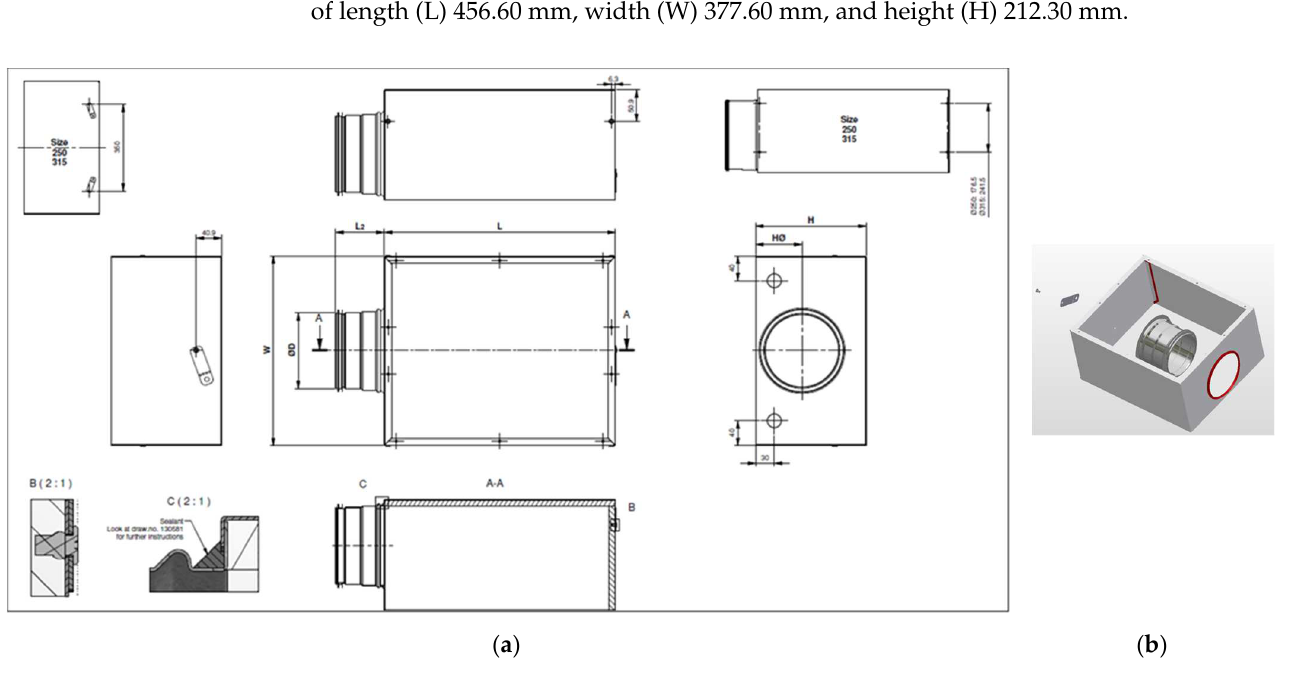
Figure 1. Drawing ( a ) 2D and ( b ) 3D view of throttle valve FD